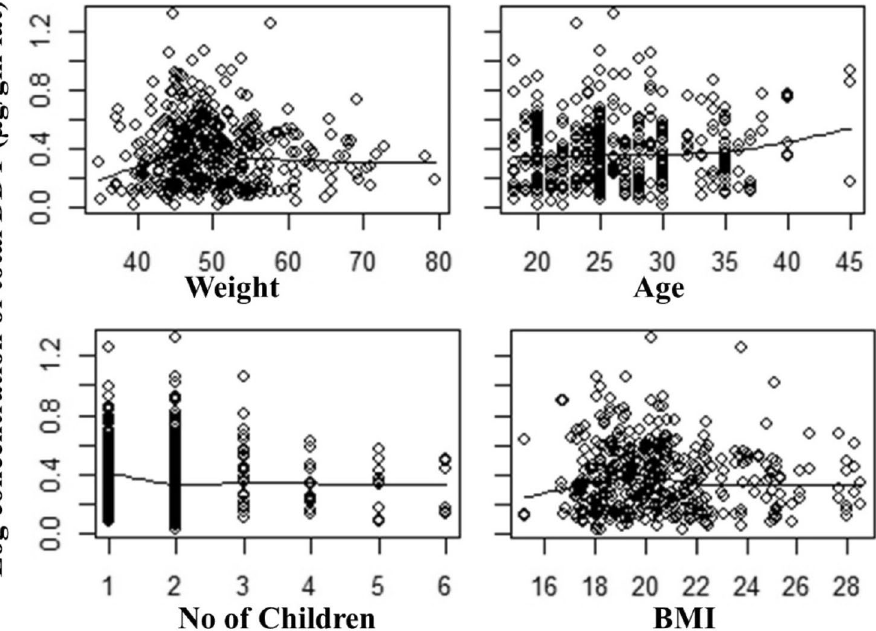
Figure 3. DDT related variables for breast milk samples collected in three districts of southwestern Ethiopia.